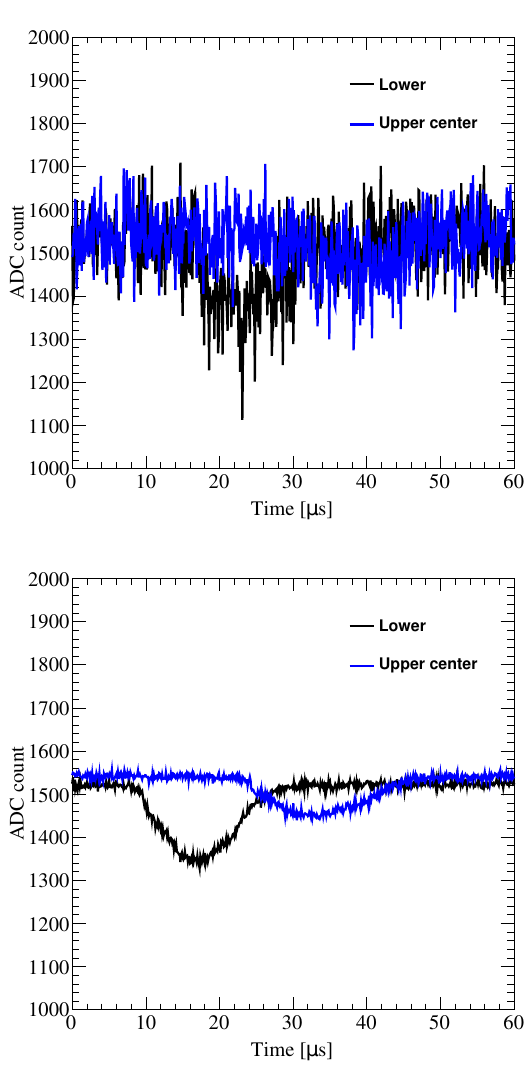
Figure 8. The waveform of CLF events. Upper: Single event. Lower: Averaged over 133 shots. Blue is center of upper viewing detector and black is lower viewing detector